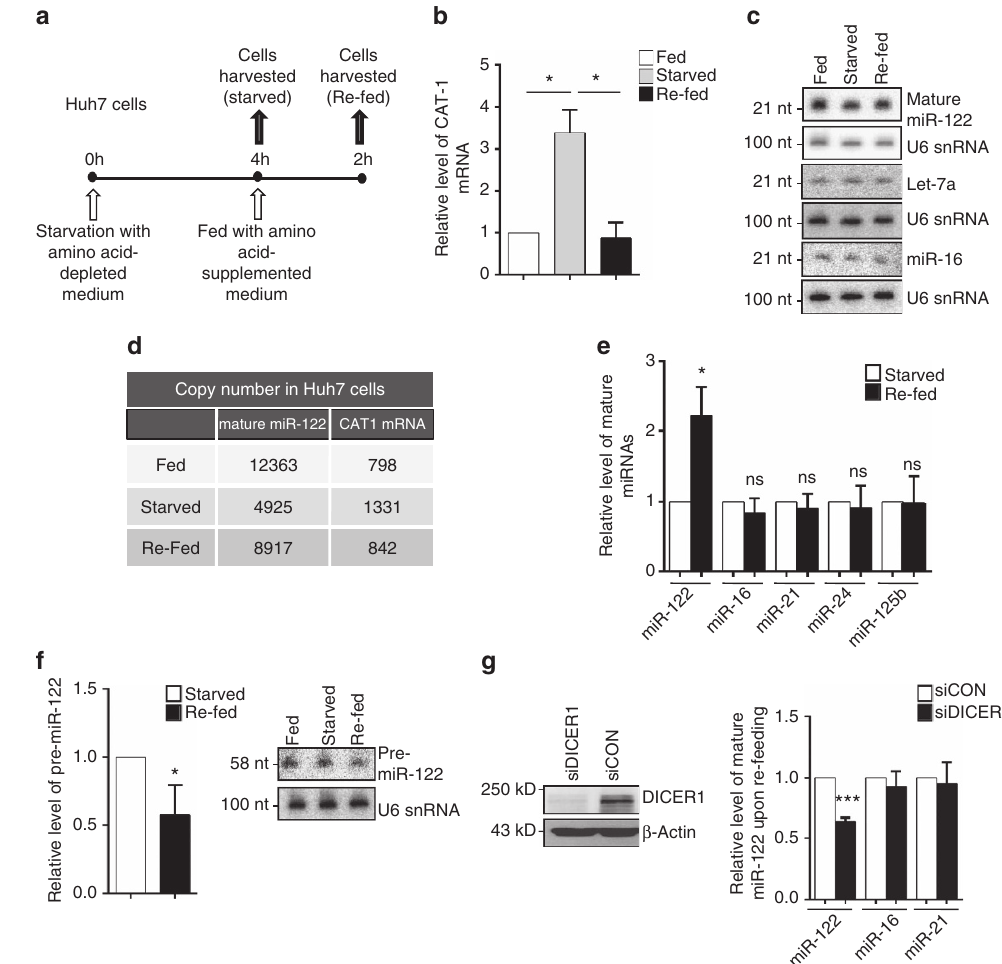
Figure 1 | Reversal of amino acid-starvation-induced stress increases miR-122 biogenesis in Huh7 cells. ( a , b ) Outline of the experimental set-up used ( a ). Relative level of CAT-1 mRNA in Huh7 cells either fed or starved for 4h and re-fed with media containing amino acids for another 2h. CAT-1 mRNA levels were quantified by quantitative reverse transcriptase-PCR with levels in Fed cells taken as 1 ( b ). ( c ) Effect of starvation and re-feeding on mature miR- 122 levels in Huh7 cells. Total RNA was extracted and 8 m g RNA was used for northern blotting of mature miR-122, let-7a and miR-16. U6 snRNA was used as loading control. ( d ) Copy number/number of molecules of mature miR-122 and CAT-1 mRNA per Huh7 cell calculated in fed, starved and re-fed Huh7 cells. Estimations were done by real-time-based methods. ( e ) Increase in mature miR-122 but not that of other non-relevant miRNAs, miR-16, miR-21, miR- 24 and miR-125b on relief of starvation. Real-time PCR-based quantification of mature miRNA levels in Huh7 cells starved for amino acids (4h) and subsequently re-fed (2h). ( f ) Increase in mature miR-122 is accompanied by a concomitant decrease in pre-miR-122 on re-feeding the starved cells for 2h. Cellular small RNA population was isolated by mirVANA kit to minimize possible contamination of pri-miR-122 and real-time-based assays were carried out to quantify pre-miR-122. Pre-miR-122 detected by northern blotting with 15 m g total RNA. Synthetic pre-miR-122 was used as a size marker to determine the position of the pre-miR-122 in the northern blotting. ( g ) Increase of mature miR-122 on re-feeding of starved cells is reduced in DICER1 knockdown Huh7 cells. miR-16 and miR-21 did not show any significant change. siDICER1-mediated knockdown of DICER1 is confirmed by western blotting. Paired